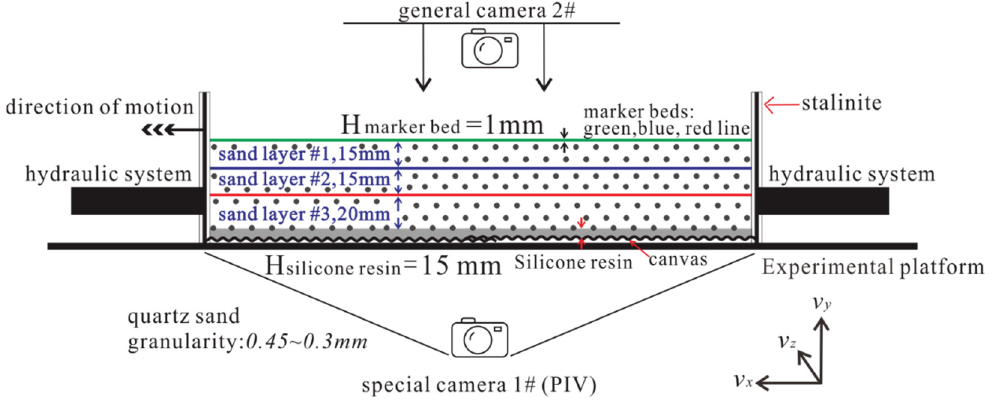
Figure 2. The schematic representation of the simulation chamber.